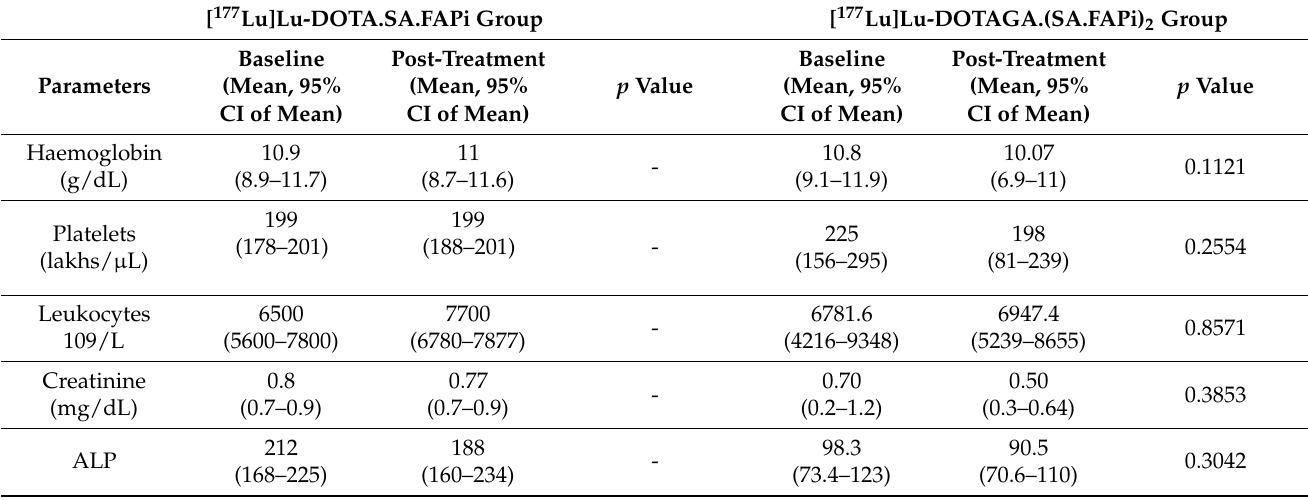
Table 3. Comparison of hematological, renal, and liver function parameters pre- and at median of 6 months post-treatment. [ 177 Lu]Lu-DOTA.SA.FAPi